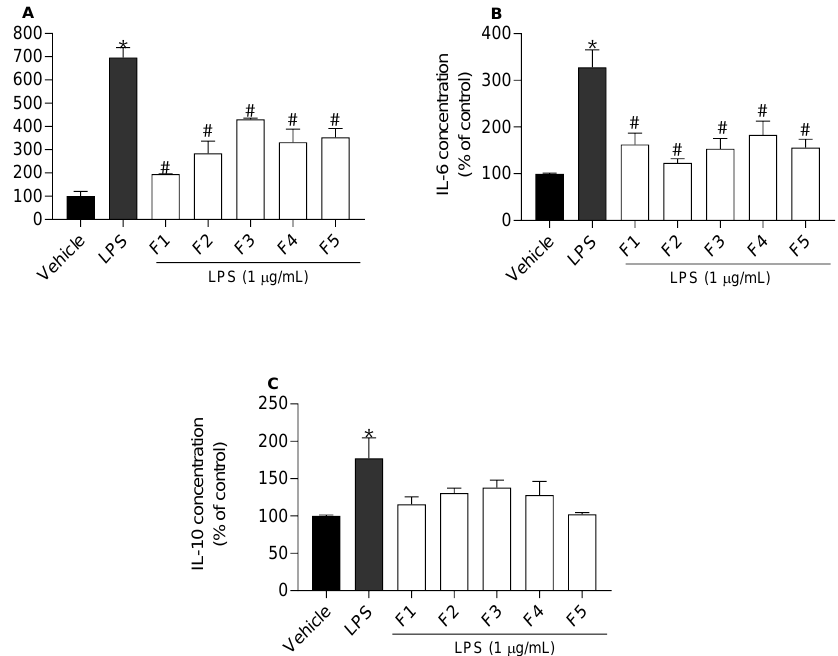
Figure 6. Concentration levels of TNF- α ( A ), IL-6 ( B ) and IL-10 ( C ) cytokines on RAW 264.7 cells treated with LPS (1 µg/mL) in the presence of Saccorhiza polyschides fractions (20 µg/mL). Symbols represent significant differences (one-way ANOVA, Dunnett’s test; p < 0.05) when compared to vehicle (*) and LPS (#).